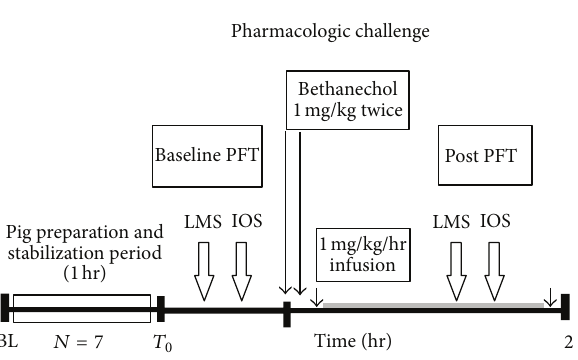
Figure 1: A schematic diagram illustrating the current test para- digm. LMS, least mean squares; IOS, impulse oscillatory system; PFT, pulmonary function testing; 𝑁 , number of animals; BL, base- line; Post, after bethanechol administration. Time between the first and second bethanechol doses was